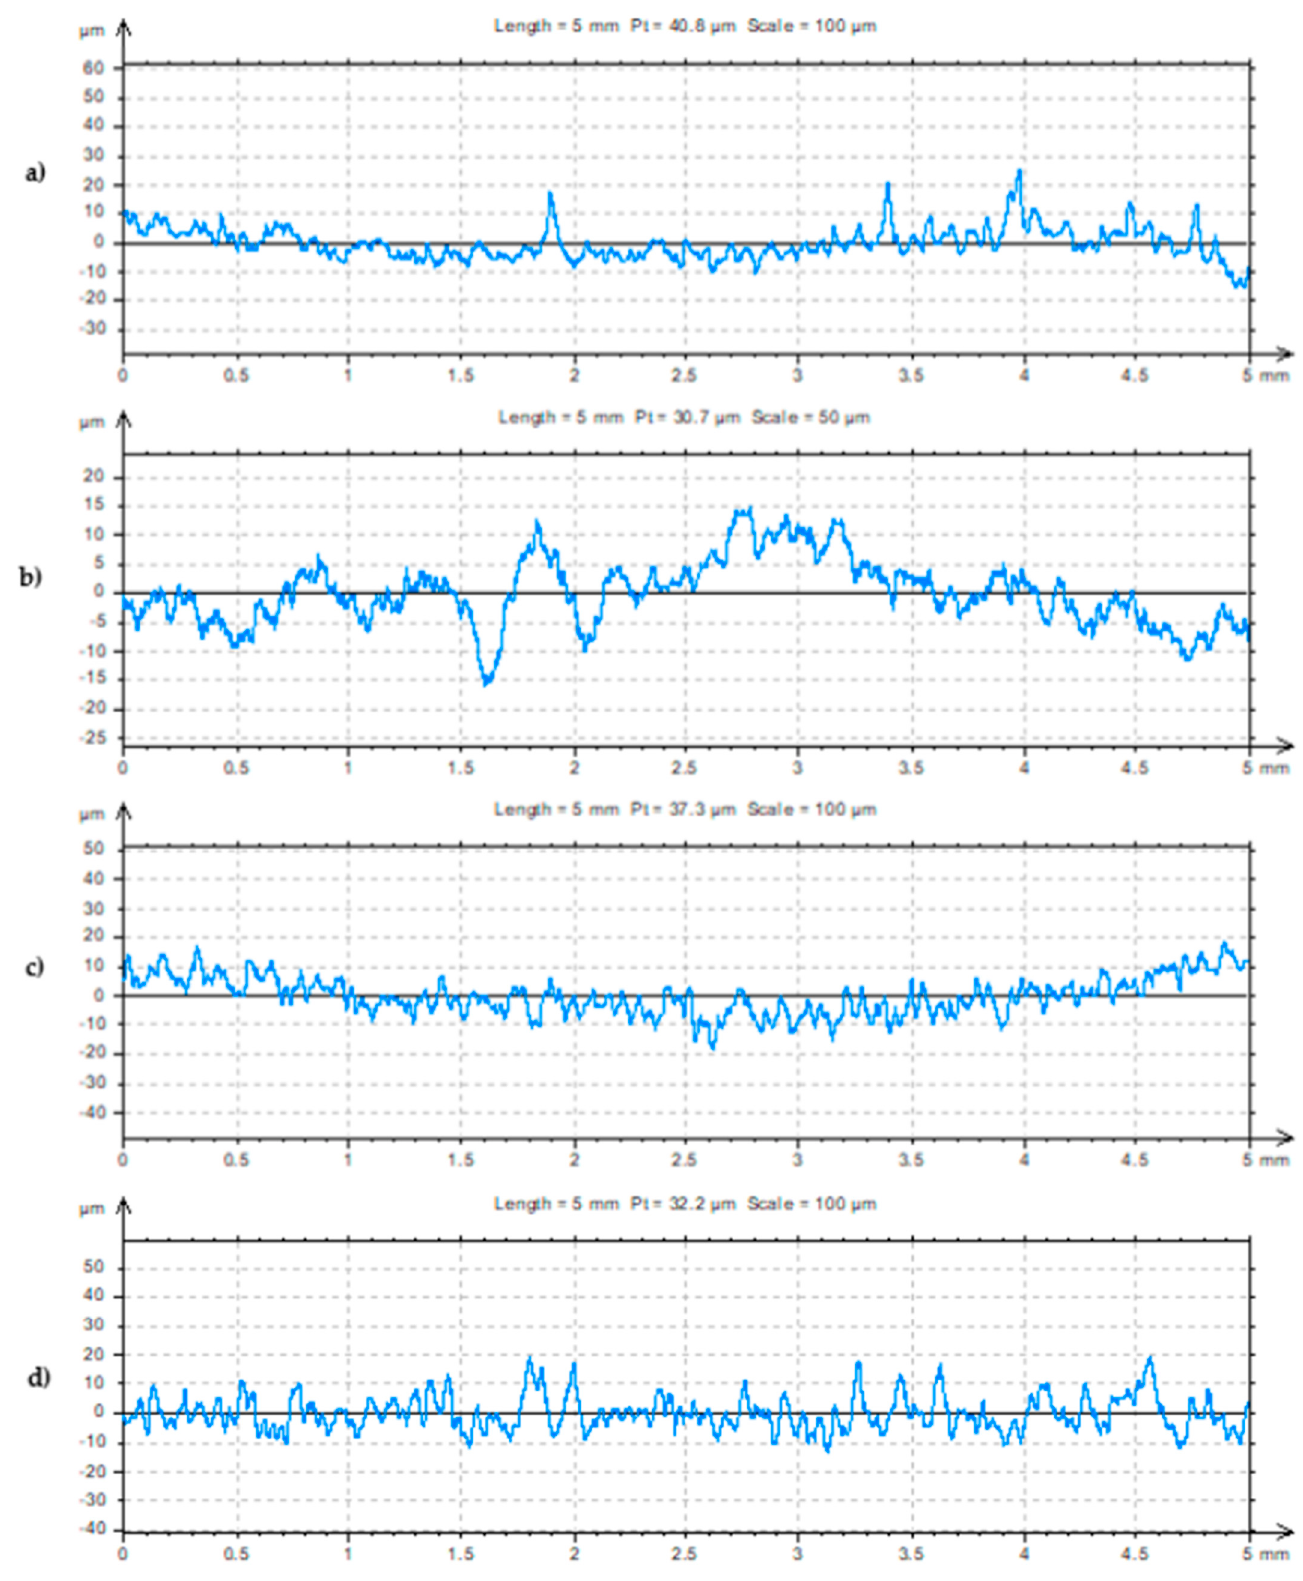
Figure 4. Profile line representative for a given series ( a ) reference material D = 1.39, ( b ) D = 1.45, ( c ) D = 1.27, and ( d ) D = 1.22.